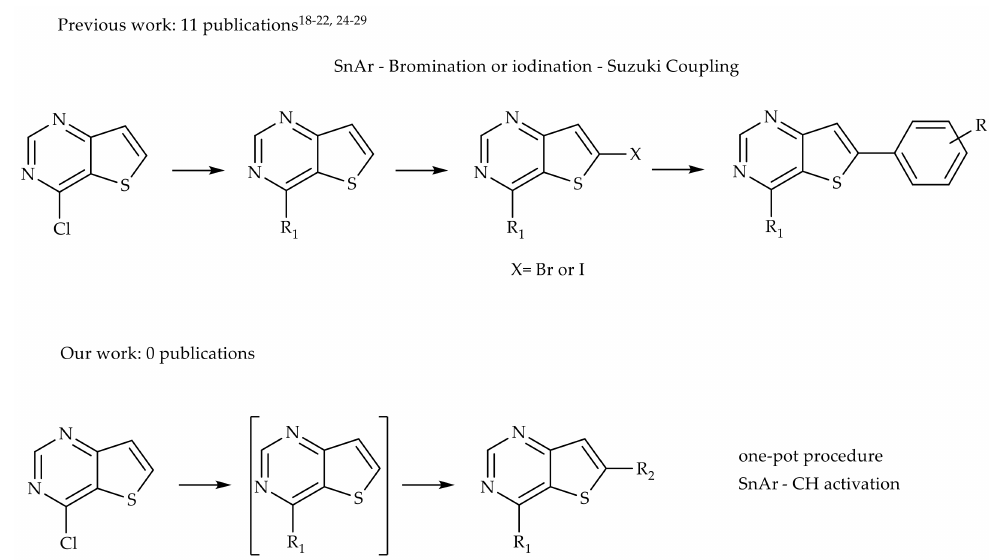
Figure 2. Literature and previous work.